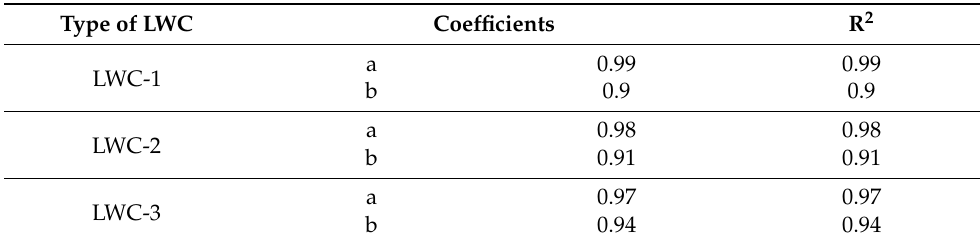
Table 6. Coefficients of the fitted curves for loss of